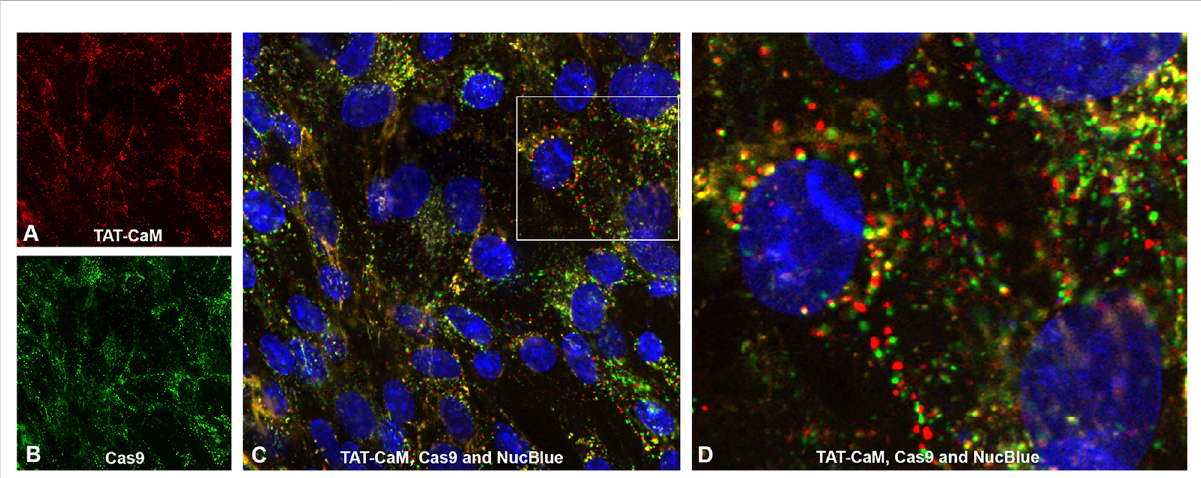
FIGURE 2 Internalization of Cas9 bound to TAT-CaM occurs readily at very low concentration. Cas9-NLS bound to equimolar TAT-CaM at 100 nM was incubatedwithBHKcellsinDMEMwith10%FBSfor1 hpriortoPBStreatment,washingandimaging.Panelsshow (A) 550-labeledTAT-CaM, (B) 488- labeled Cas9-NLS and (C) Composite including NucBlue. In (D) the enlarged inset (Figure 2D) shows Cas 9-NLS and TAT-CaM are often in separate but juxtaposed